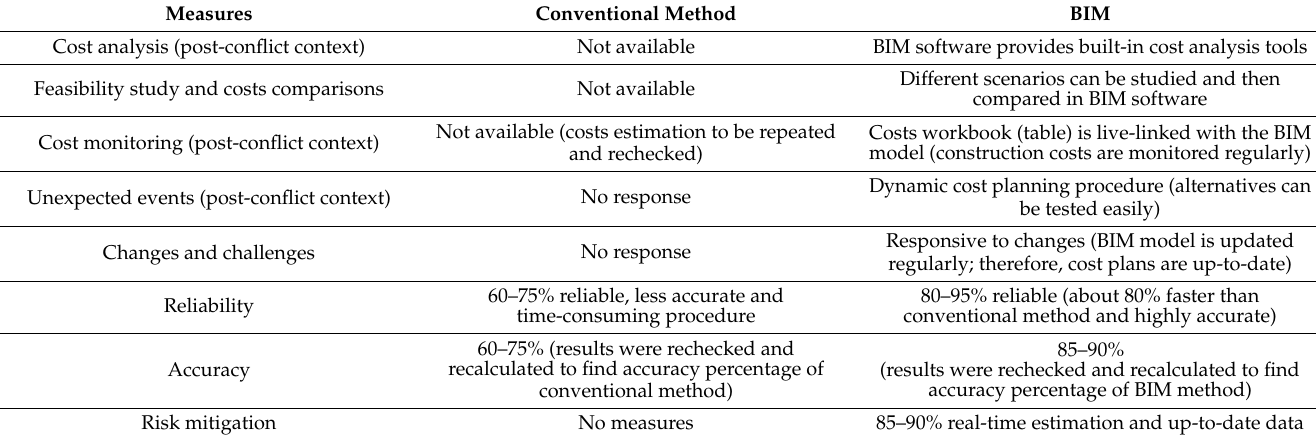
Table 6. Cost planning in post-conflict contexts: conventional method vs. BIM.